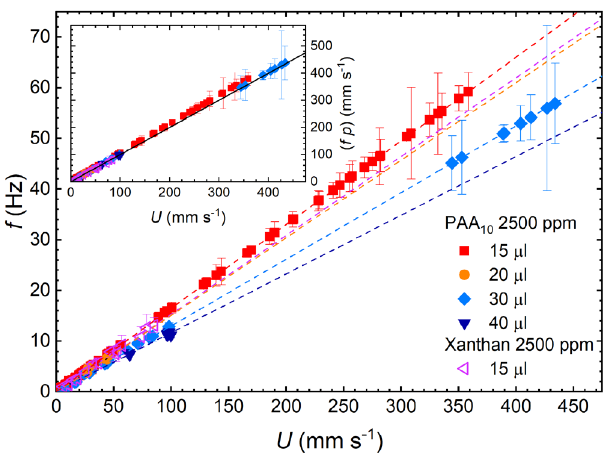
Fig. 4 Oscillation frequency of descending polymeric drops. Oscillation frequency f as a function of the average drop speed U for the polyacrylamide solution PAA 10 and Xanthan 2500ppm drops of different volume deposited on lubricated surfaces impregnated with silicone oil of different viscosities. The dashed lines are linear fi ts to the data. The inset displays all the data in terms of the product fp versus U , where p is the length of the drop free contour. The straight line has a slope equal to 1. The error bars represent one standard